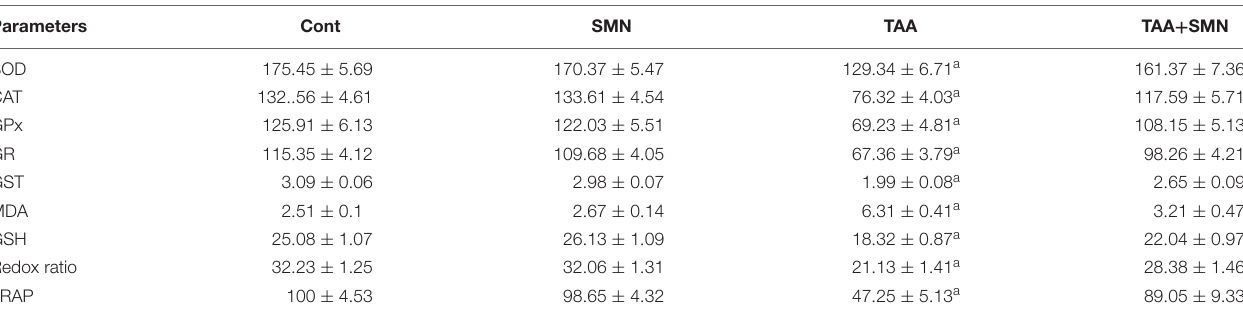
TABLE 4 | Effect of TAA and SMN on antioxidant enzymes activities in kidney